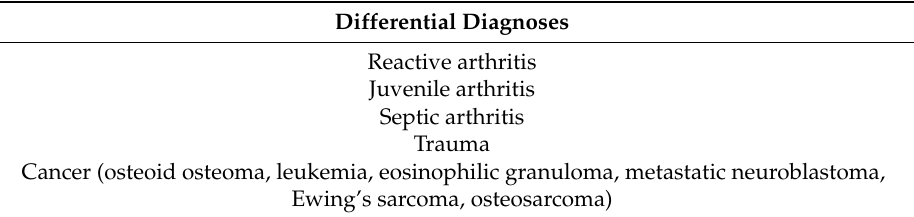
Table 2. Differential